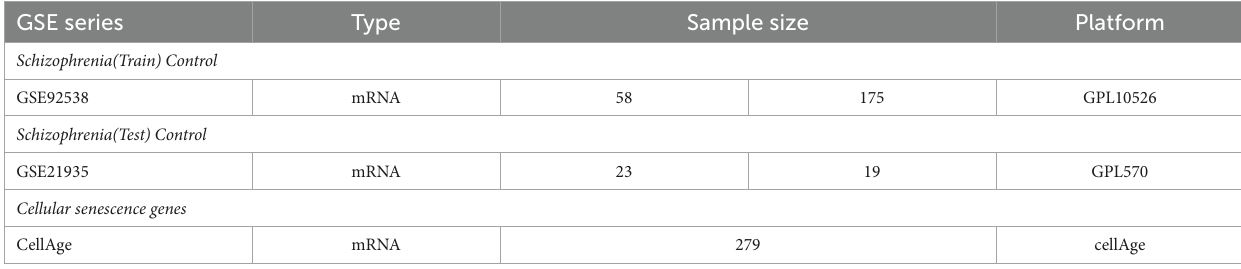
TABLE 1 Detailed data set